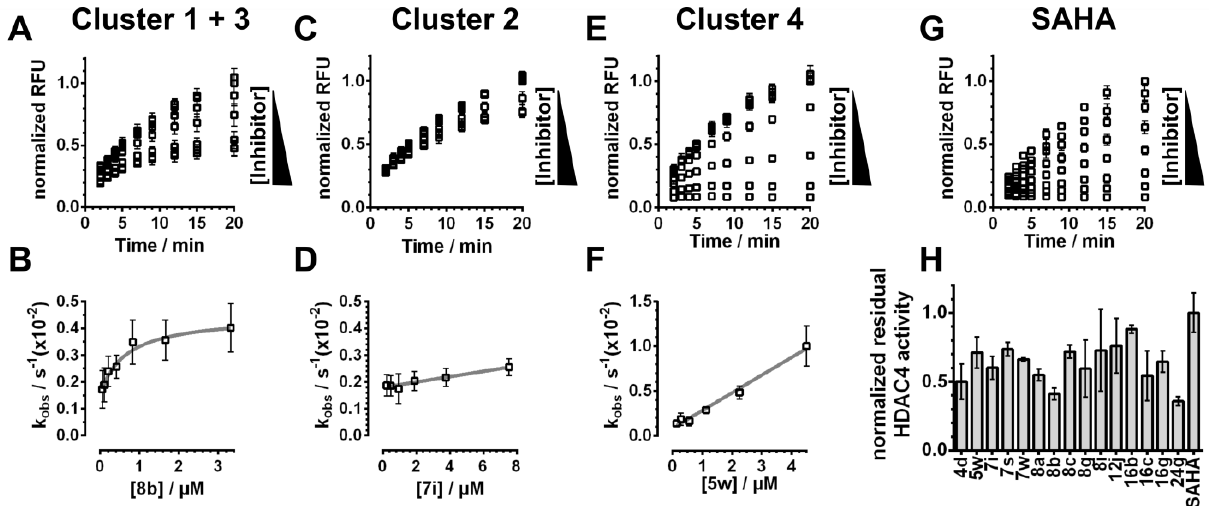
Figure 4. Association kinetics of HDAC4 and TZD ligands from different structural clusters . The association kinetics correlates with the chemical structure of TZD ligands and is substantially different between compound clusters 1–4. ( A – F ) Cluster 1 + 3, cluster 2 and cluster 4 are represented by TZD ligands 8b , 7i and 5w , respectively. ( G ) Association kinetics of reference compound SAHA. ( H ) Residual cdHDAC4 wt activity 15 min after rapid dilution of all 15 tested TZD ligands and SAHA. Shown data represent means and standard deviations, N = 3.